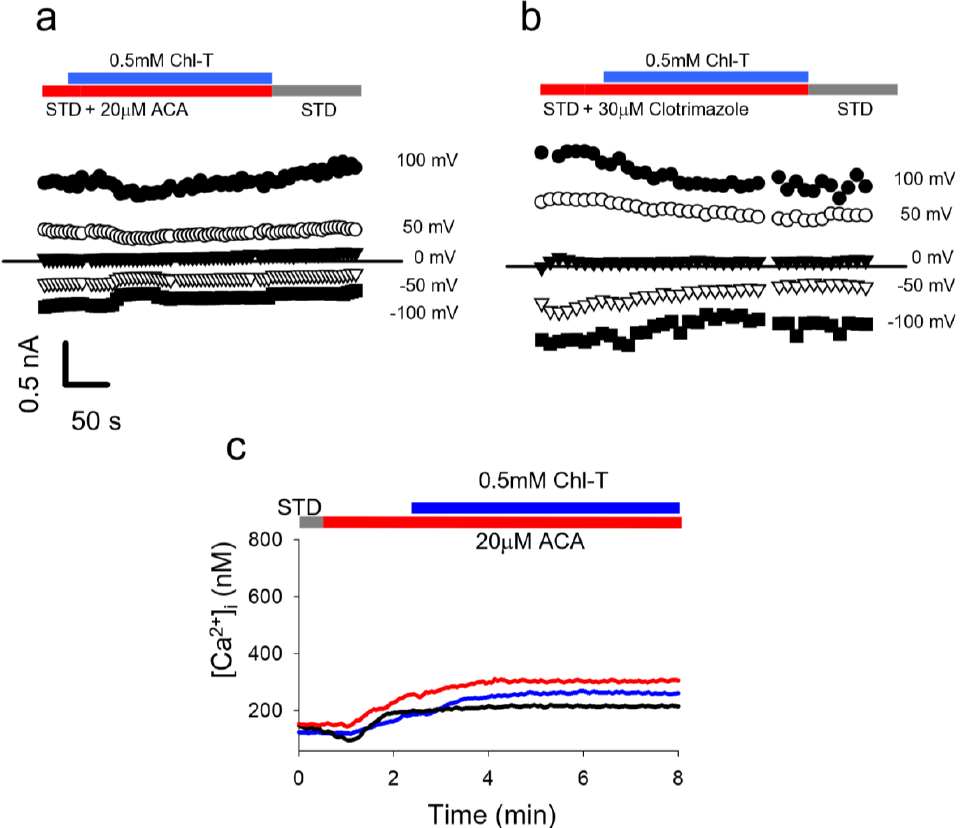
Figure 7. In IGR39 cells, TRPM2 blockers ACA and clotrimazole impede K + current activation and [Ca 2+ ]i increase by Chl-T. ( a ) Time course of currents recorded in a representative IGR39 cell during application in bath solution containing 0.5 mM ChlT and 20 µM ACA. ( b ) Similar to panel ( a ), but recorded during the addition of 30 µM clotrimazole. ( c ) Representative traces of [Ca 2+ ]i recorded in IGR39 cells after the application of 0.5 mM Chl-T with 20 µM ACA in the standard bath solution containing 2 mM Ca 2+ .